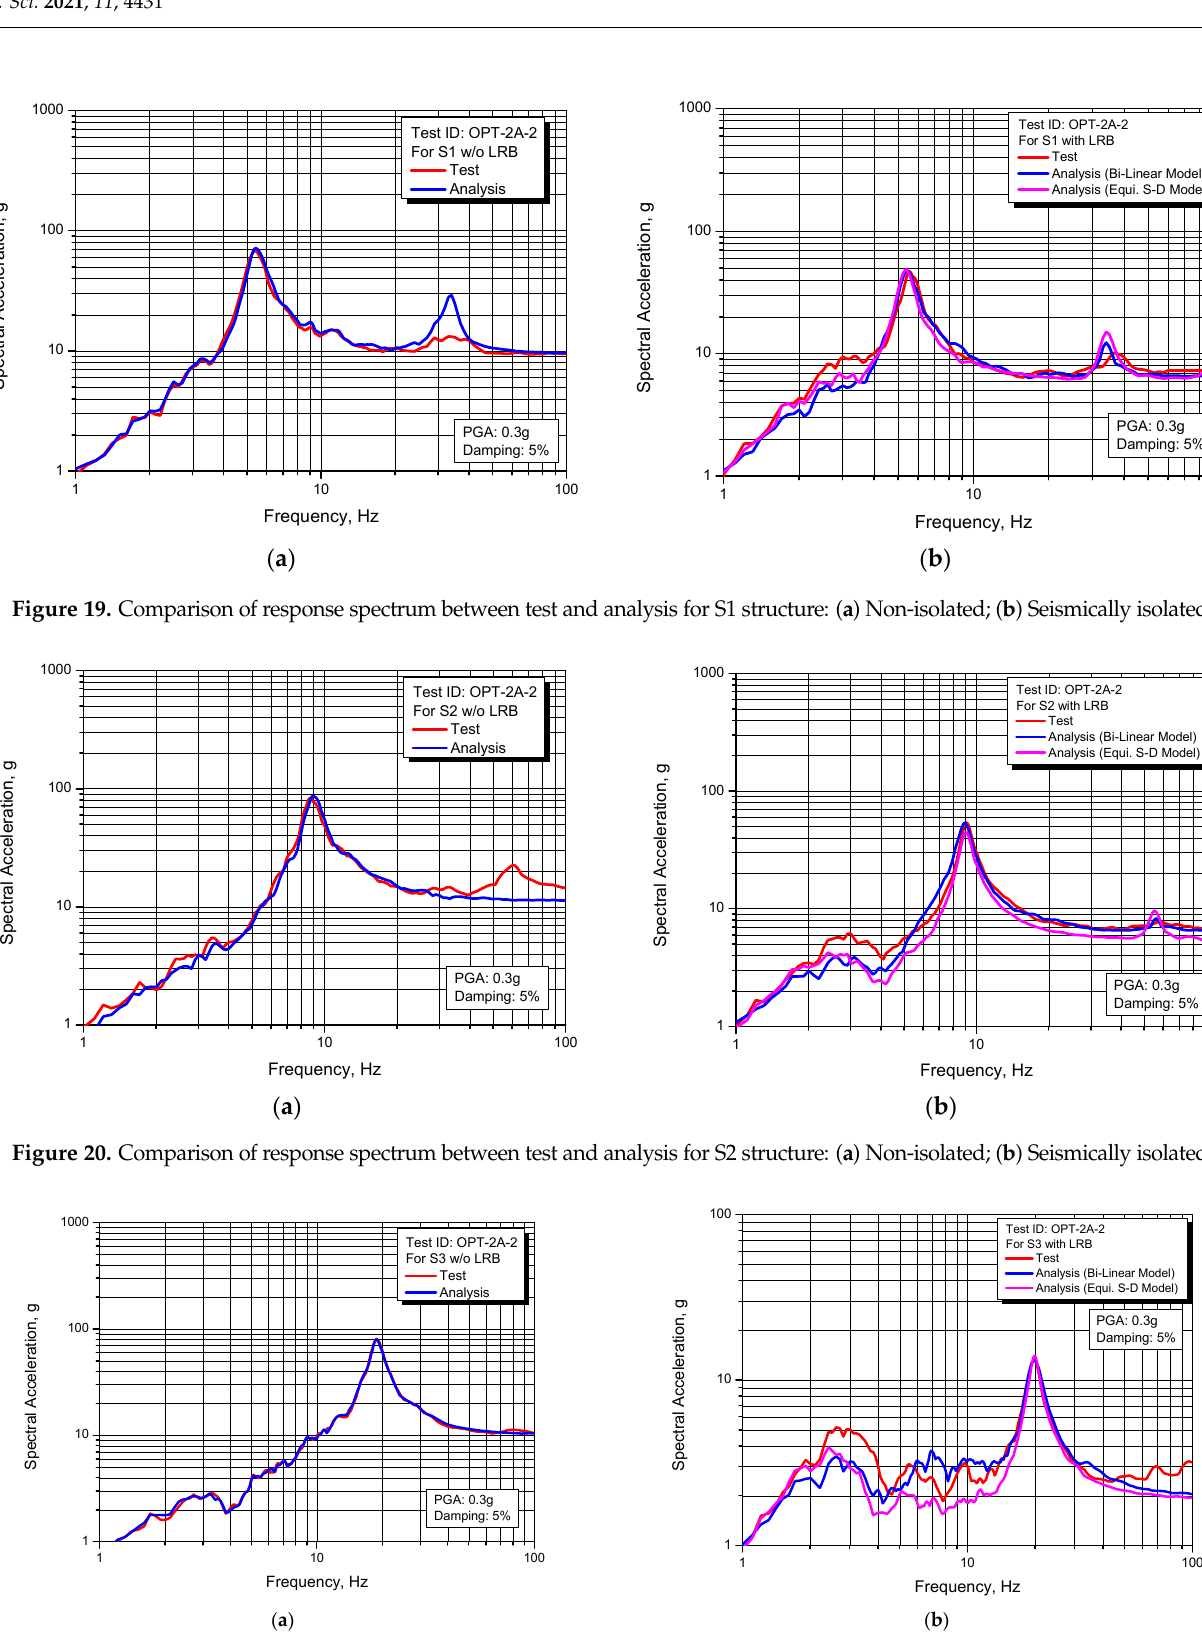
( b ) Figure 22. LRB shear displacement responses: ( a ) Comparison of maximum values; ( b ) Hysteretic response with Bi-linear model.